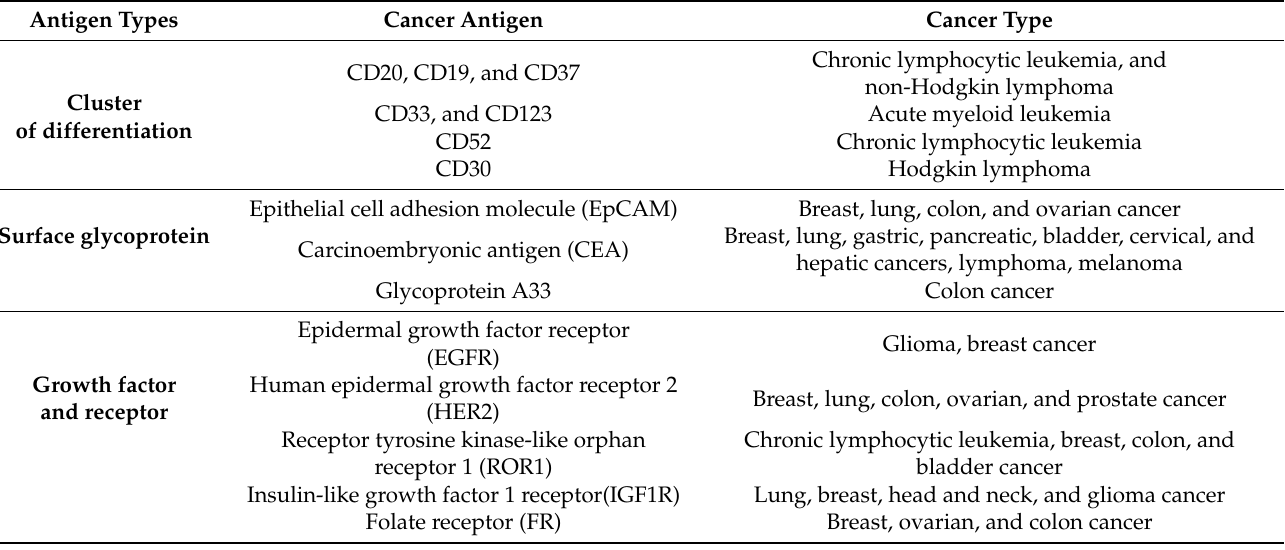
Table 2. Type of cancer antigens for